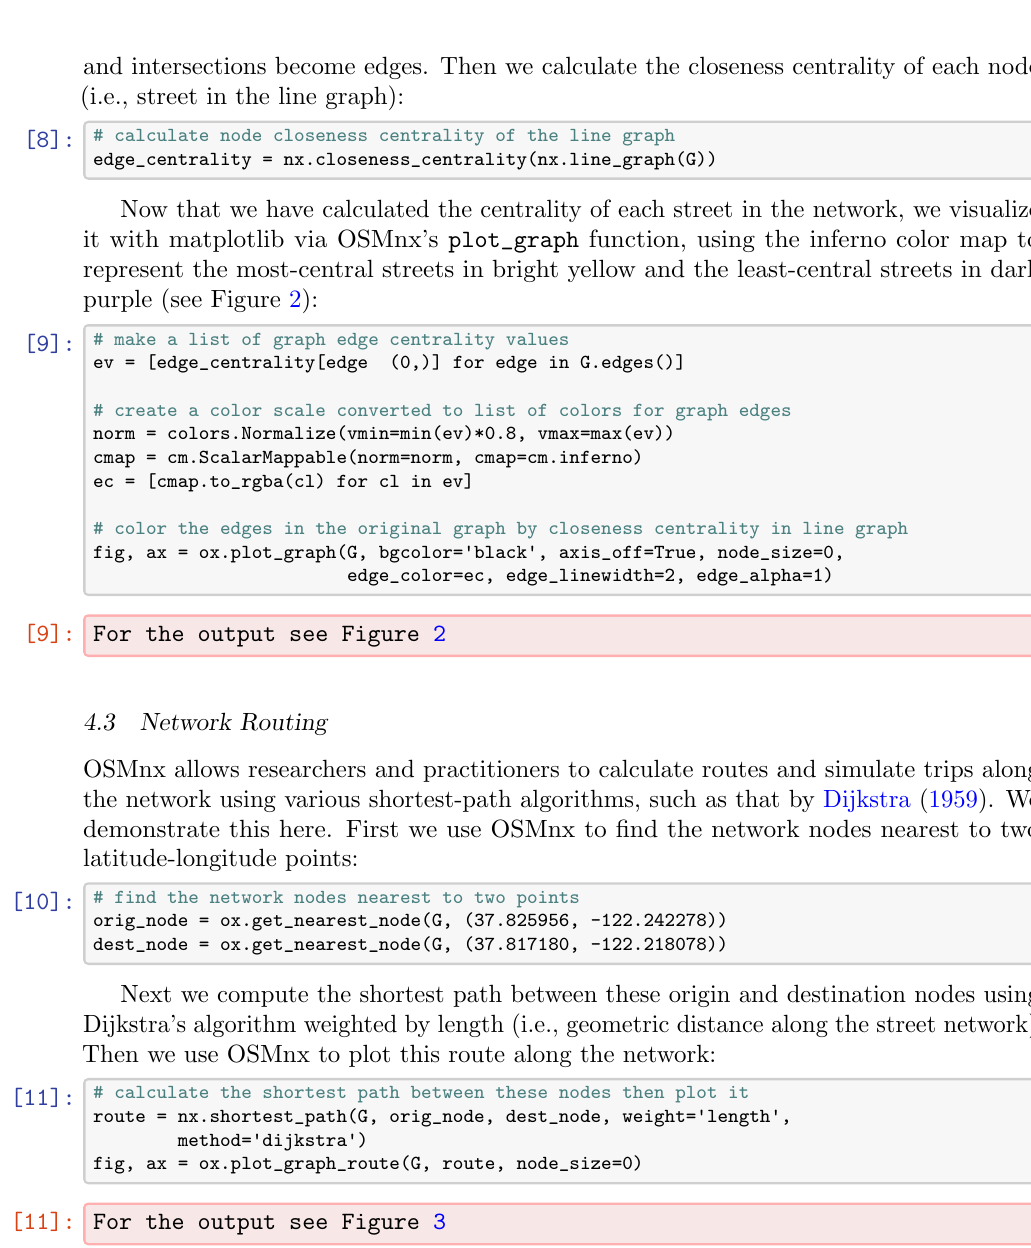
Figure 2: Output from codebox